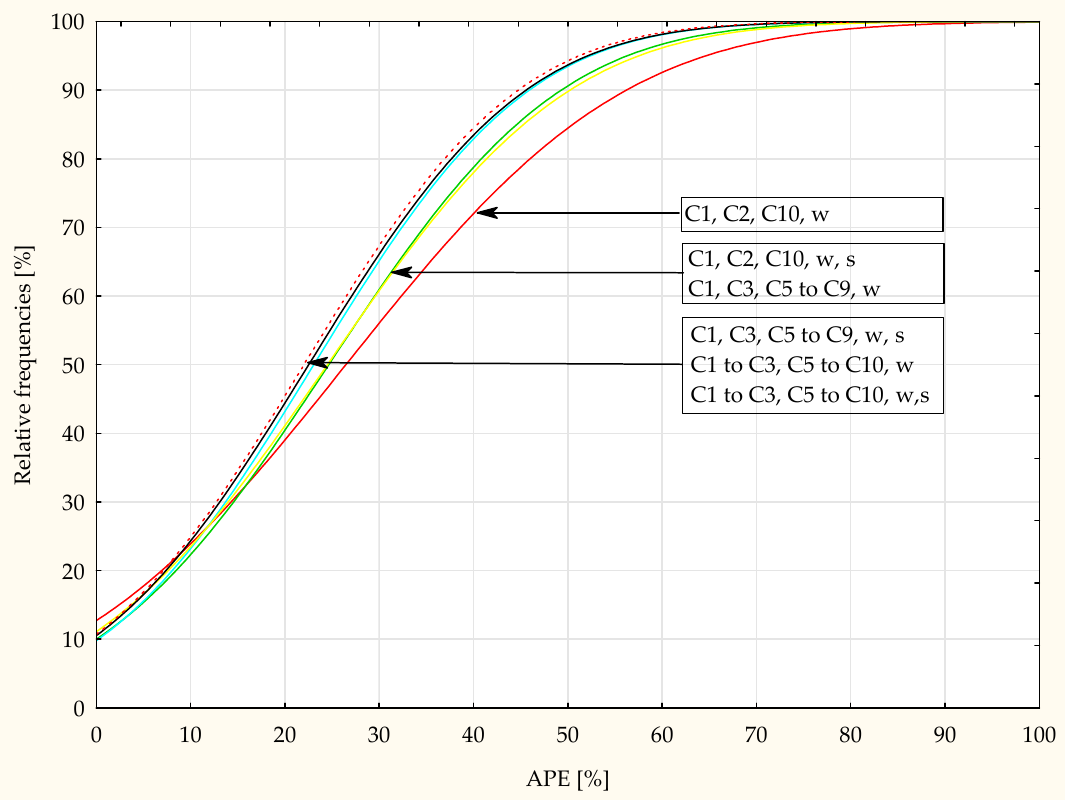
Figure 11. Distribution function of prediction errors of the mass waste accumulation from household Figure indicator.